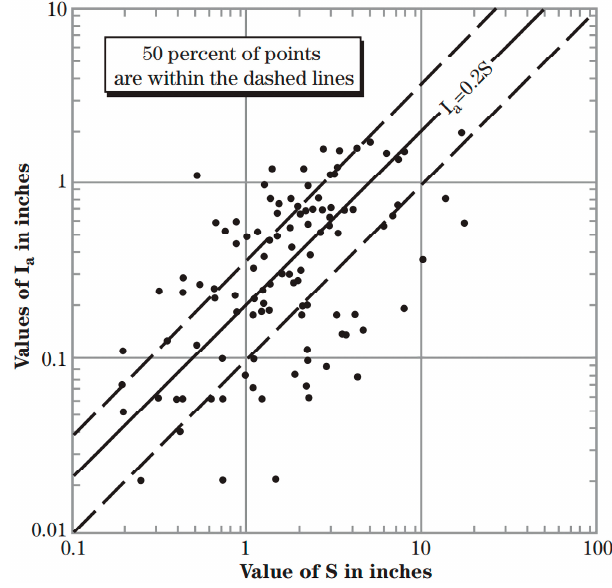
Figure 1. The original SCS data points from NEH-4 [15].